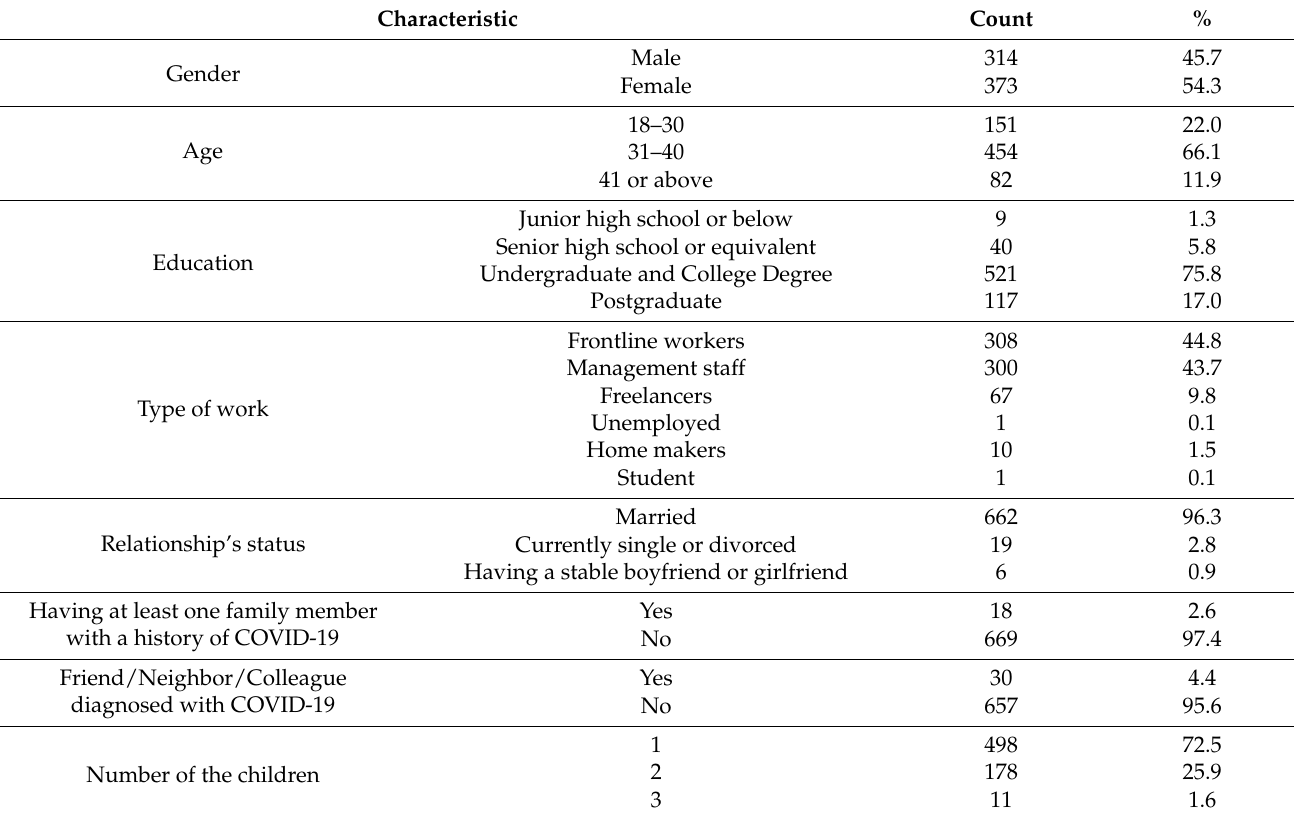
Table 1. Demographic profile of participants ( n =